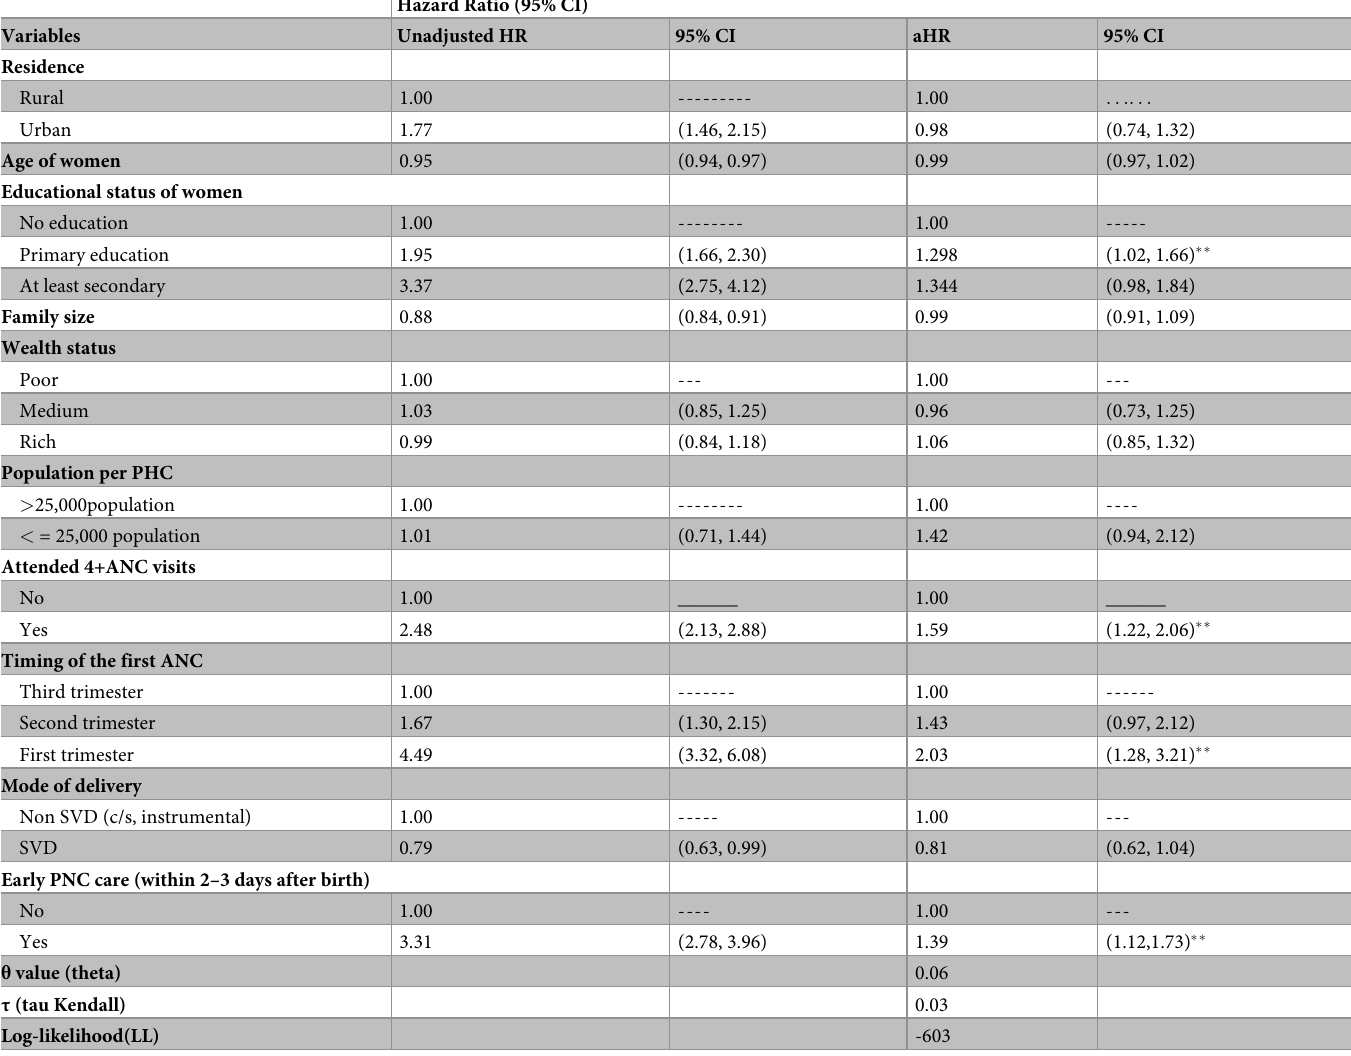
Table 3. Results of Multivariable analysis of time-to-contraceptive after childbirth by women aged 15–49 who had their most recent birth within 12 months preced- ing the survey, West Gojjam Zone, Ethiopia, June